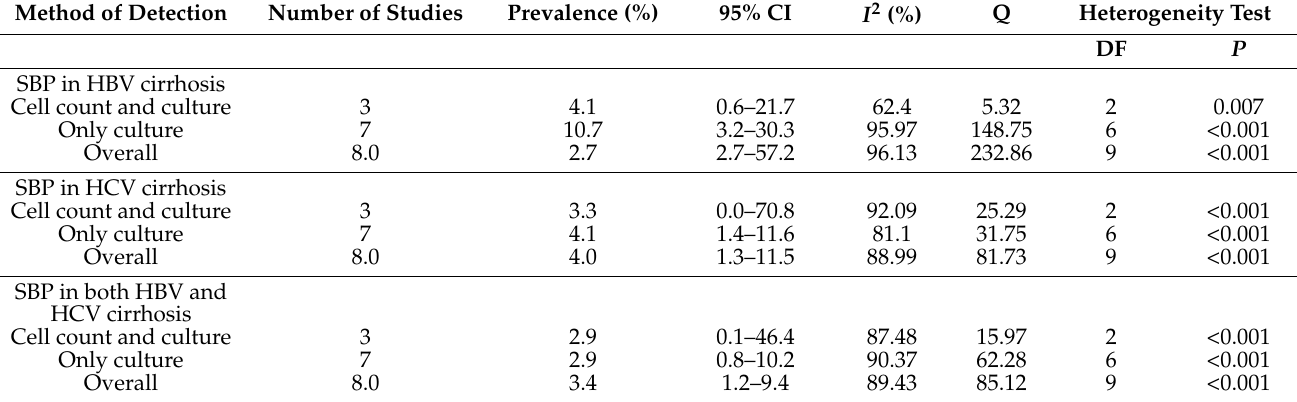
Table 6. Subgroup analysis of SBP in three different viral hepatitis-related liver cirrhosis with the detection